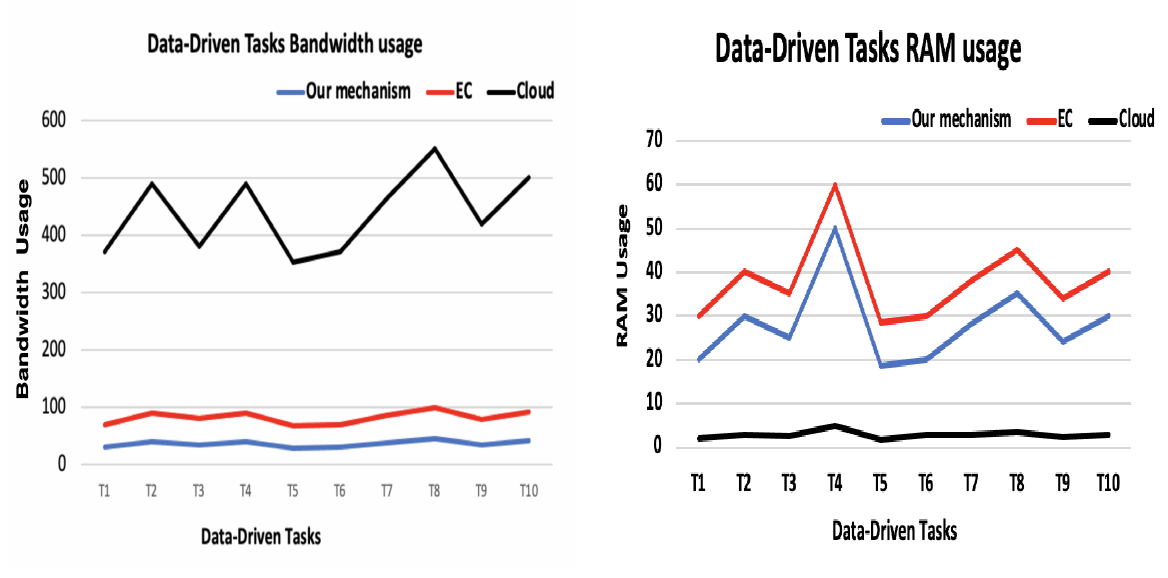
Figure 7. Data-Driven tasks bandwidth and RAM